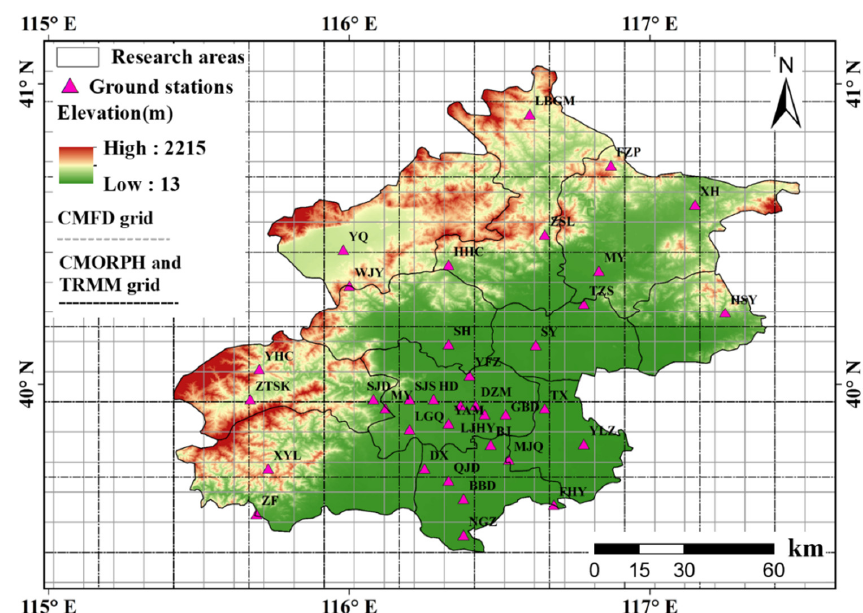
Figure 1. Locations of the meteorological stations providing ground observations and the various grids for satellite-derived precipitation products superimposed over a topographic map of the Beijing region. CMFD: China Meteorological Forcing Dataset; CMORPH: Climate Prediction Center morphing technique; TRMM: Tropical Rainfall Measuring Mission.